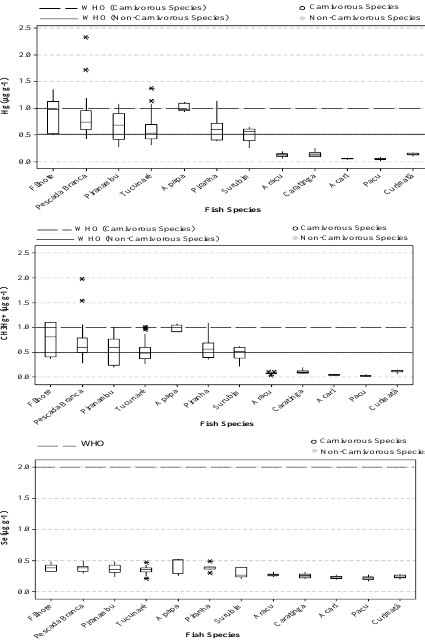
Figure 4: levels Hg, CH 3 Hg + , and Se in samples fish species (carnivorous and non-carnivorous) consumed by riverine inhabitants belonging to Barreiras community (area impacted by gold mining underground) and Tabatinga community (area without mining impact), both belonging to the Tapajós basin (Amazon,